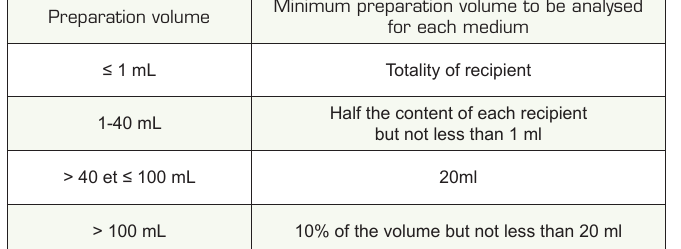
Table 9: minimum volume sample to be analysed according to the European Pharmacopoeia